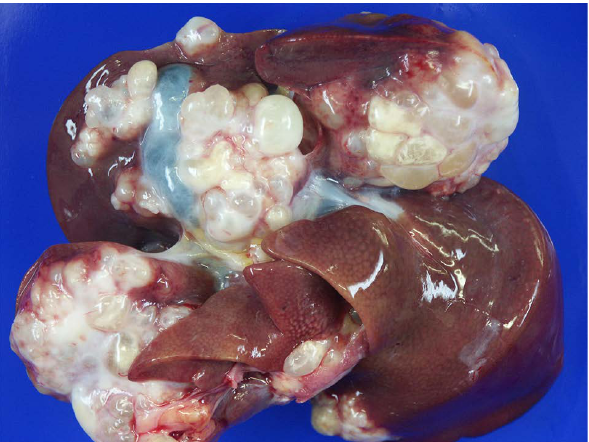
Figure 4. Gross pathology of a hepatic echinococcosis. The par- asites invade the liver tissue with multiple cystic transformation. Echinococcus multilocularis infection of a rhesus monkey of the German Primate Center.